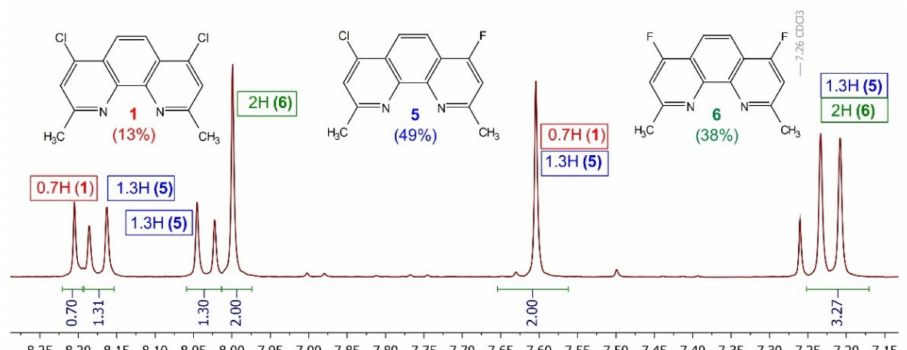
Figure 2. 1 H NMR spectrum (CDCl 3 ) of the mixture of 1 , 5 , and 6